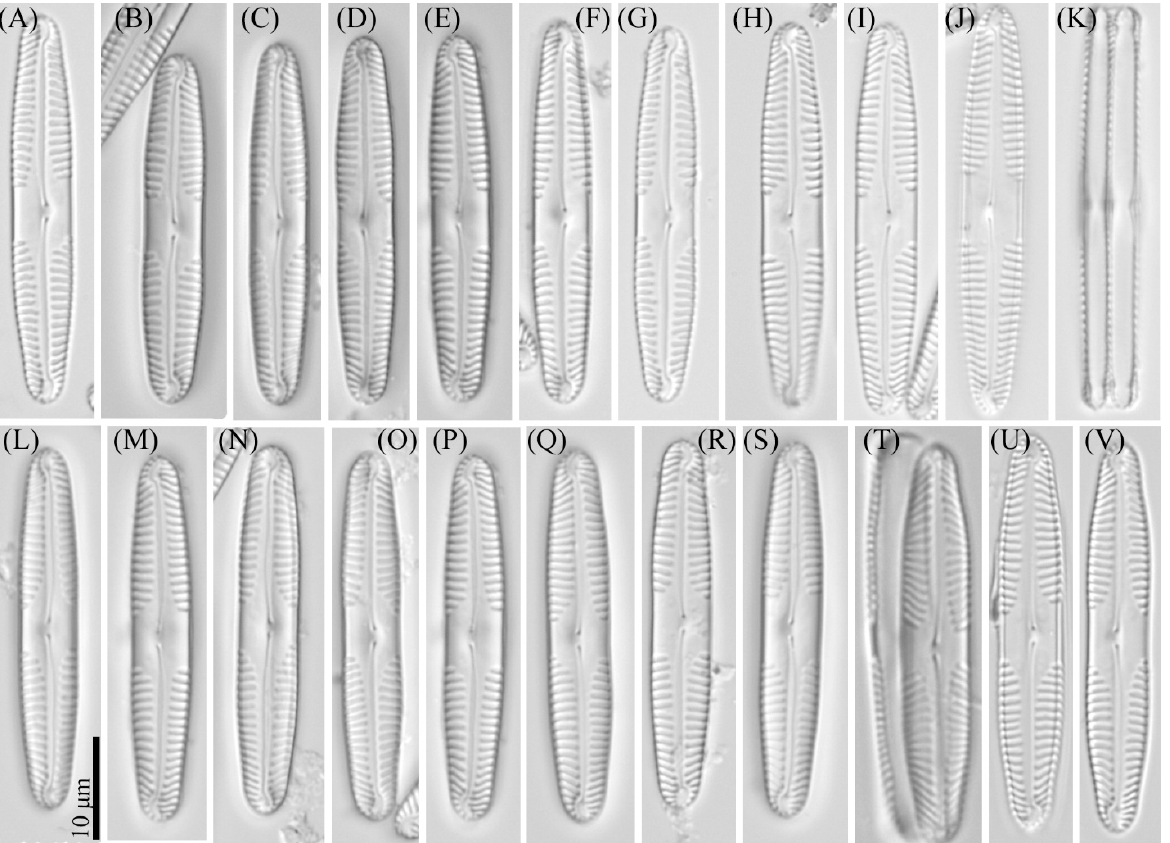
Figure 7. Pinnularia microgibba Kezlya, Maltsev, Krivova et Kulikovskiy sp. nov. Strains VP289 slide No. 07047, VP292. slide No. 07050. Light microscopy, differential interference contrast. ( A – J ) Strains VP289 valve face (arrows indicate the ghost striae). ( A ) Holotype. ( L – S ) Strain VP290 valve face (arrows indicate the ghost striae). ( K ) С ell in girdle view. ( T – V ) Valves from the wild sample.